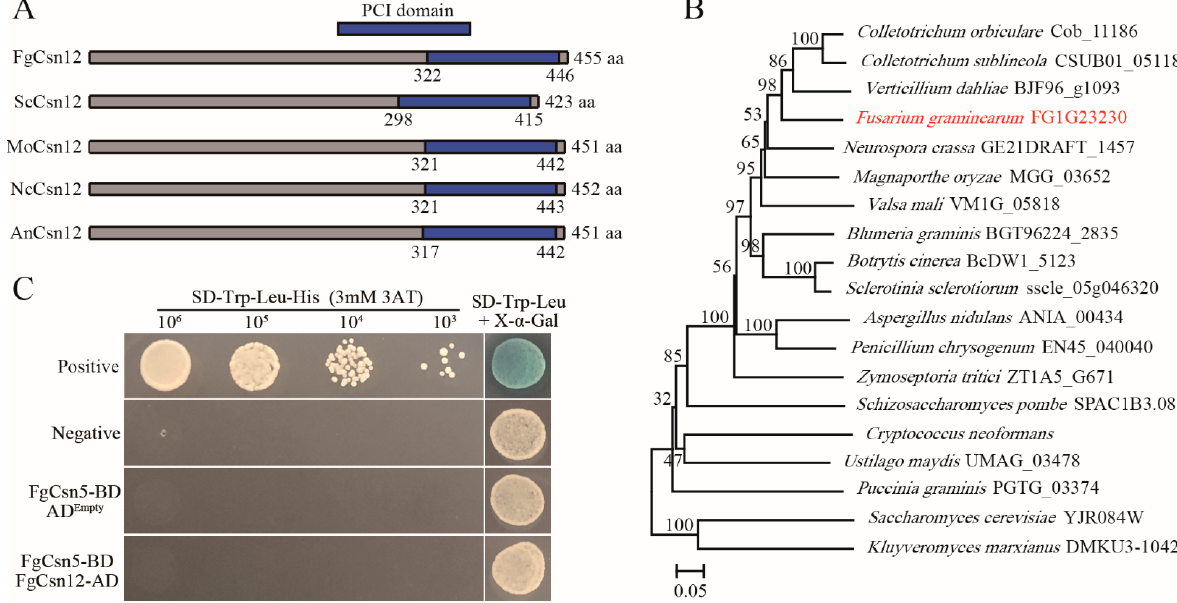
Figure 1. Phylogenetic analysis of FgCSN12 and its interaction with FgCSN5 . ( A ) Schematic drawing of the conserved domains of FgCsn12, ScCsn12, MoCsn12, NcCsn12, and AnCsn12 in F. graminearum , S. cerevisiae , Magnaporthe oryzae , Neurospora crassa , and Aspergillus nidulans . The PCI domain is labeled with a blue box. ( B ) Phylogenetic analysis of full-length amino acid sequences of FgCsn12 and its orthologs from S. cerevisiae , Schizosaccharomyces pombe , M. oryzae , N. crassa , A. nidulans , Botrytis cinerea , Sclerotinia sclerotiorum , Cryptococcus neoformans , Zymoseptoria tritici , Colletotrichum orbiculare , Colletotrichum sublineola , Verticillium dahliae , Valsa mali , Blumeria graminis , Penicillium chrysogenum , Ustilago maydis , Puccinia graminis , and Kluyveromyces marxianus . The phylogenetic tree was constructed by the neighbor-joining method using MEGA5 software [27]. The bootstrap values shown were estimated based on 1000 replications. The red font represents FgCsn12 in F. graminearum . ( C ) Different concentrations of yeast cells (cells/mL) of the transformants expressing the indicated bait and prey constructs (left) were assayed for growth on SD-Trp-Leu-His plates and LacZ activities.